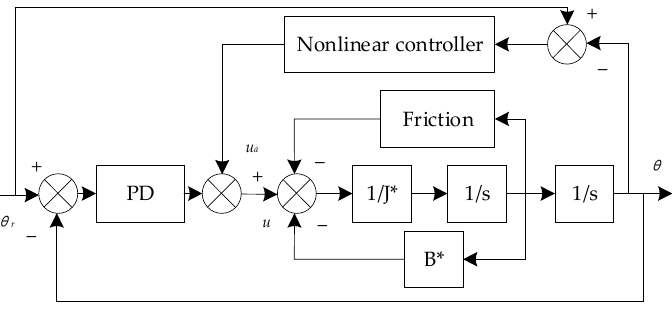
Figure 9. Block diagram of an implementation of a controller [66]. Torque feedback control involves installing a sensor of the measured motor output on the coupling shaft and forming a loop through feedback to achieve control. To overcome this problem, Carneiro and de Almeida [67] explored the use of a pneumatic actuation solution, that is, the pneumatic linear peristaltic actuator (PLPA). Experiments showed that, contrary to what happens with low-friction actuators, the use of integral action does not limit cycles. Furthermore, a zero steady-state control error was obtained in the